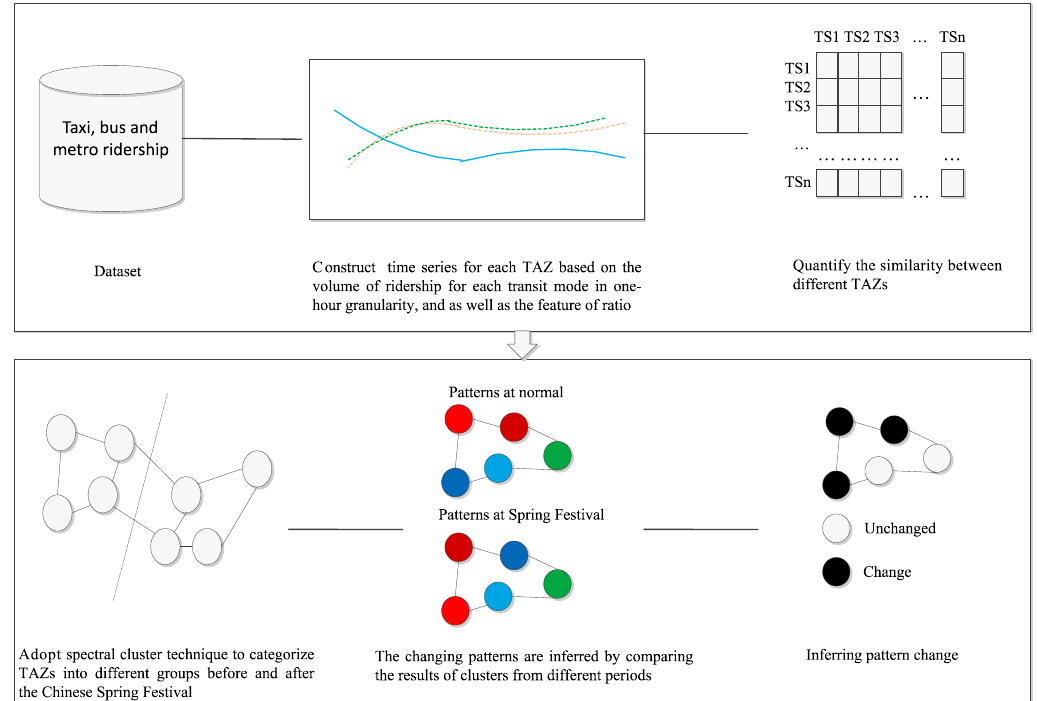
Figure 3. Method to identify multi-modal transit patterns. TAZs: traffic analysis zones.